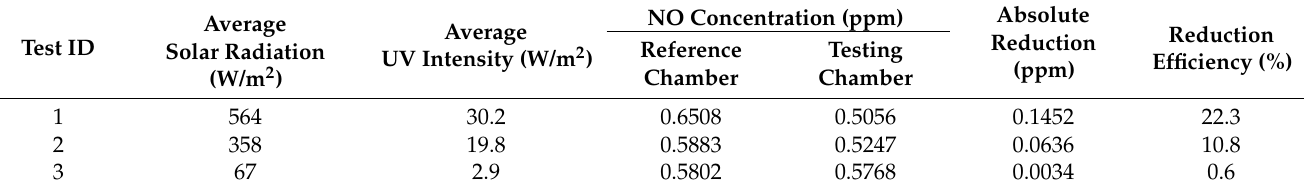
Table 6. Summary of NO Absolute Reduction and Reduction